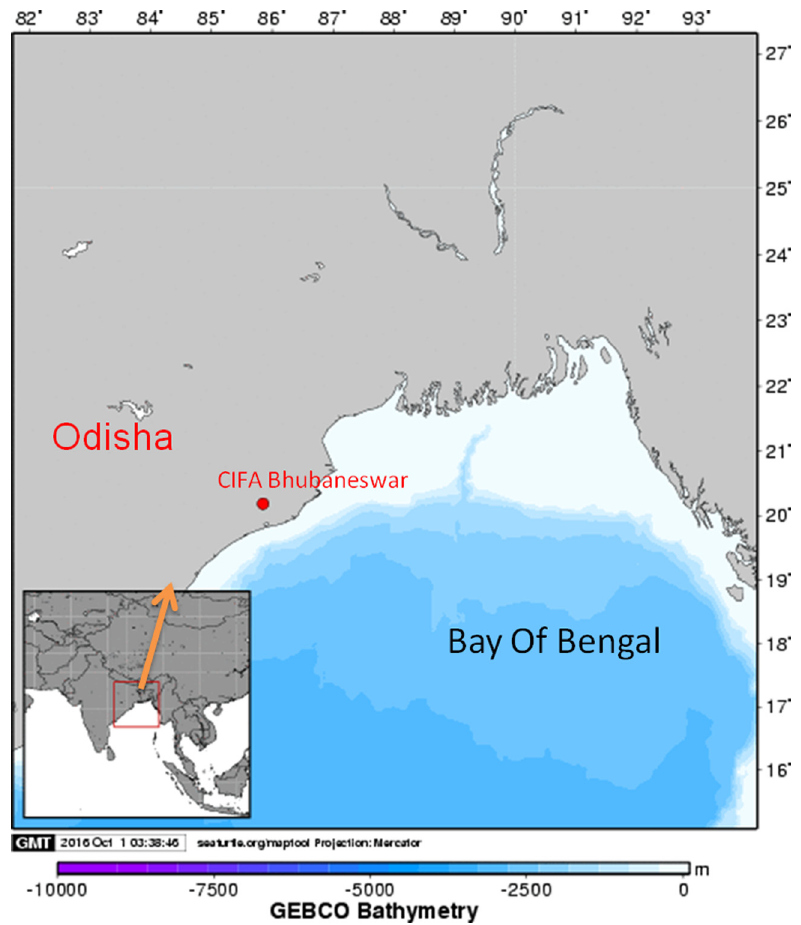
Fig. 1. Experimental pond location at Central Institute of Freshwater Aquaculture, Kausalyaganga, Bhubaneswar, Odisha,